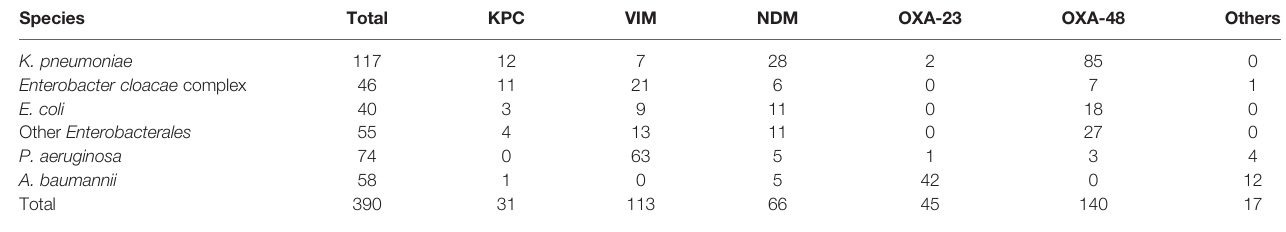
TABLE 2 | Number and type of carbapenemases the most prevalent species encoded.